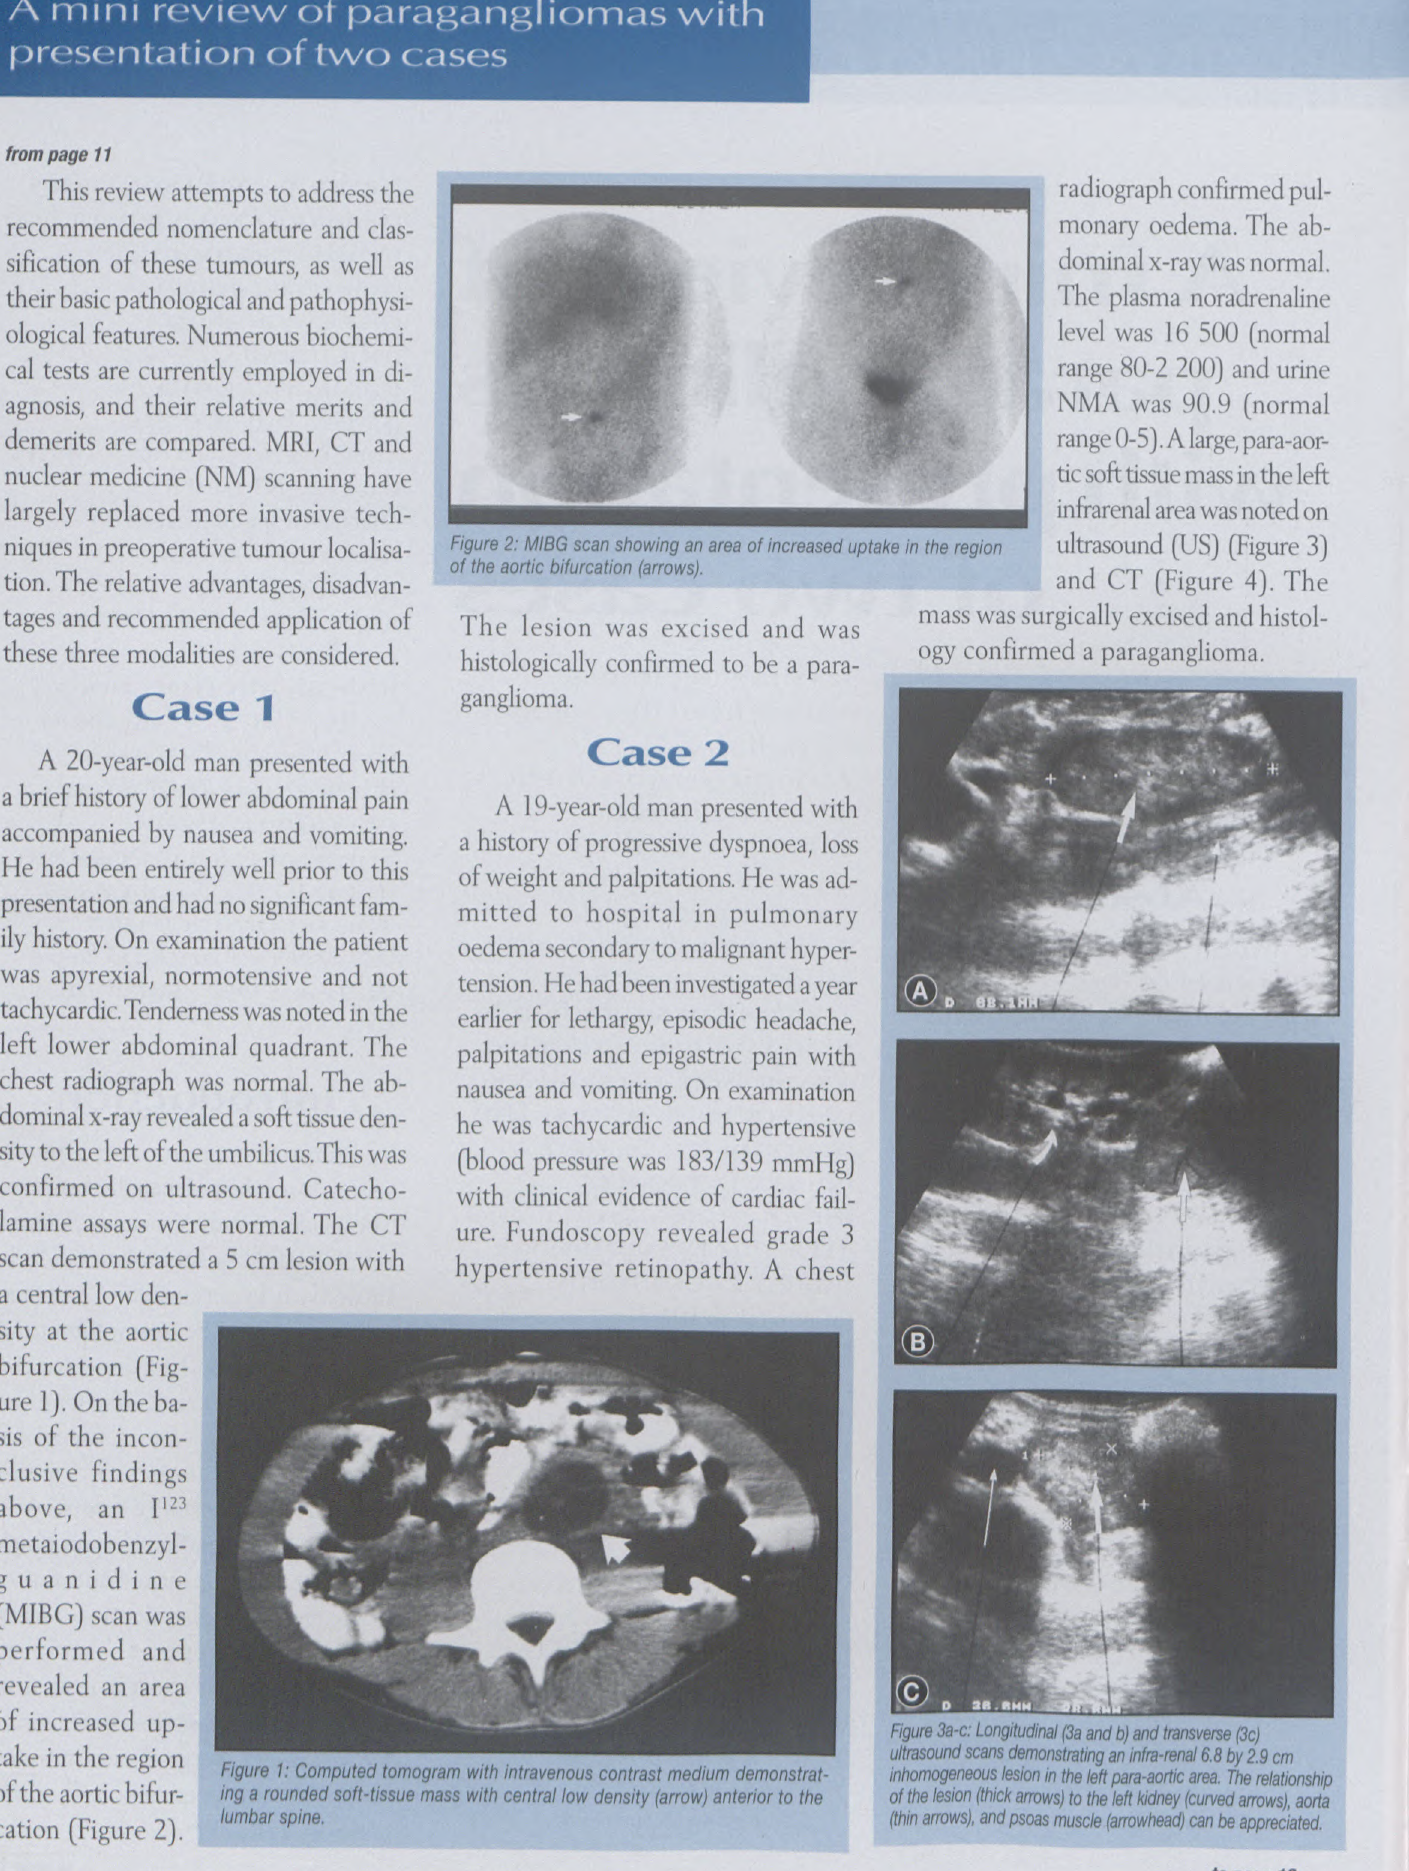
Figure 1: Computed tomogram with intravenous contrast medium demonstrat- ing a rounded soft-tissue mass with central low density (arrow) anterior to the lumbar spine.